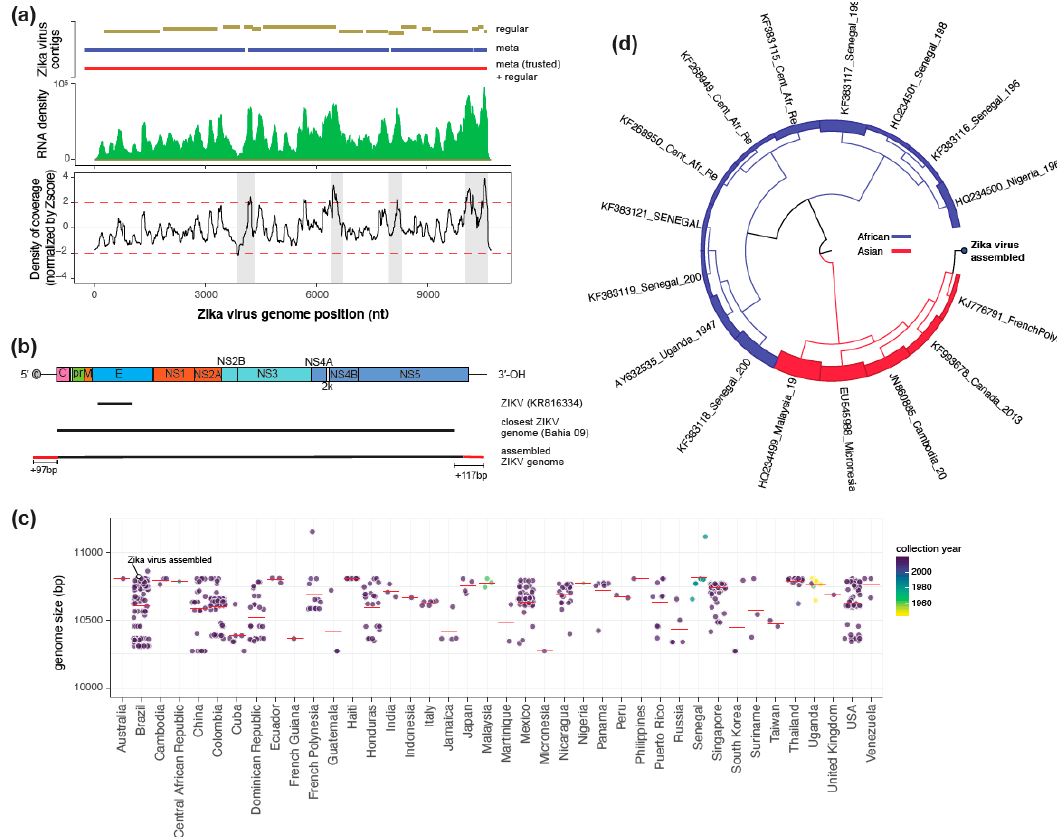
Figure 1. Significant improvement of the Zika virus genomic sequence identified in the 2015 outbreak in Bahia ‐ Brazil. ( a ) Overview of assembly strategies and RNA coverage of the Zika virus genome. For each of the assembly strategies, contigs larger than 500nt were represented as continuous vertical bars.